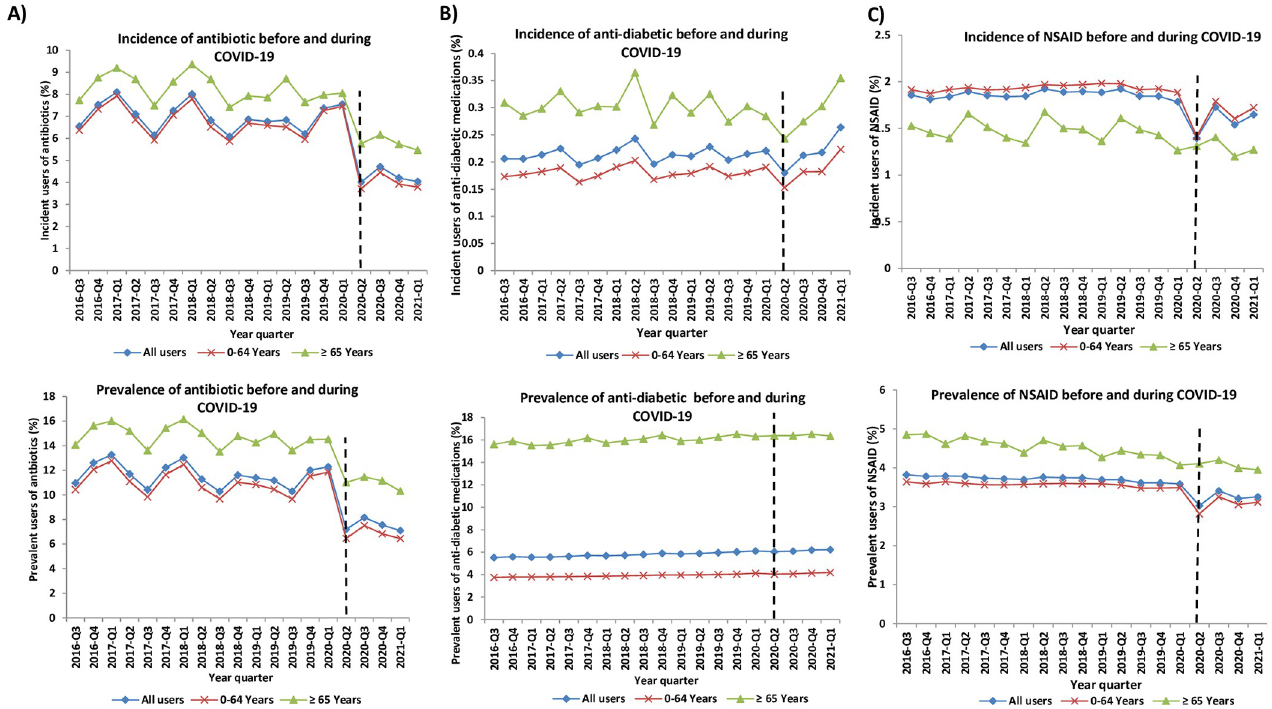
Fig 3. Incidence and Prevalence of (A) Antibiotic, (B) Anti-diabetic and (C) Non-steroidal anti-inflammatory drugs use stratified by age in Manitoba from Q3-2016 until